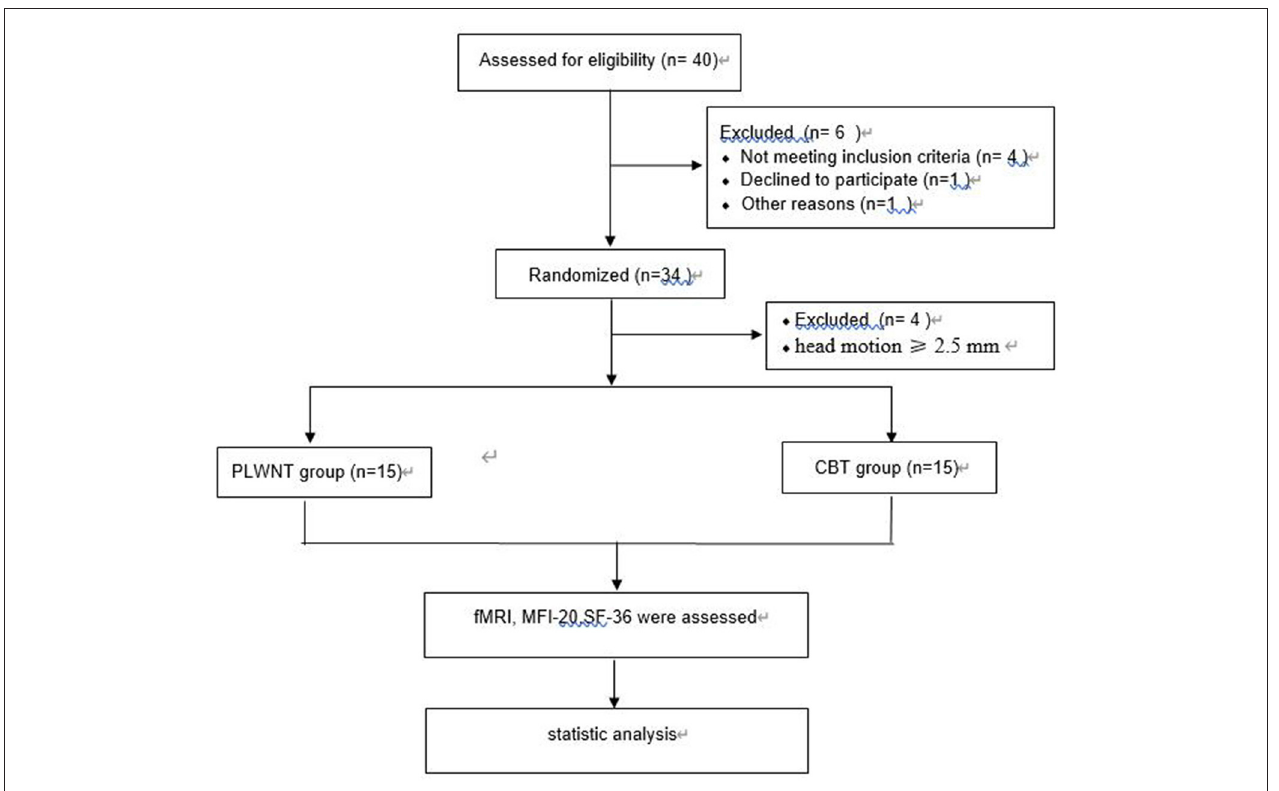
FIGURE 2 | Flow diagram of the study design.